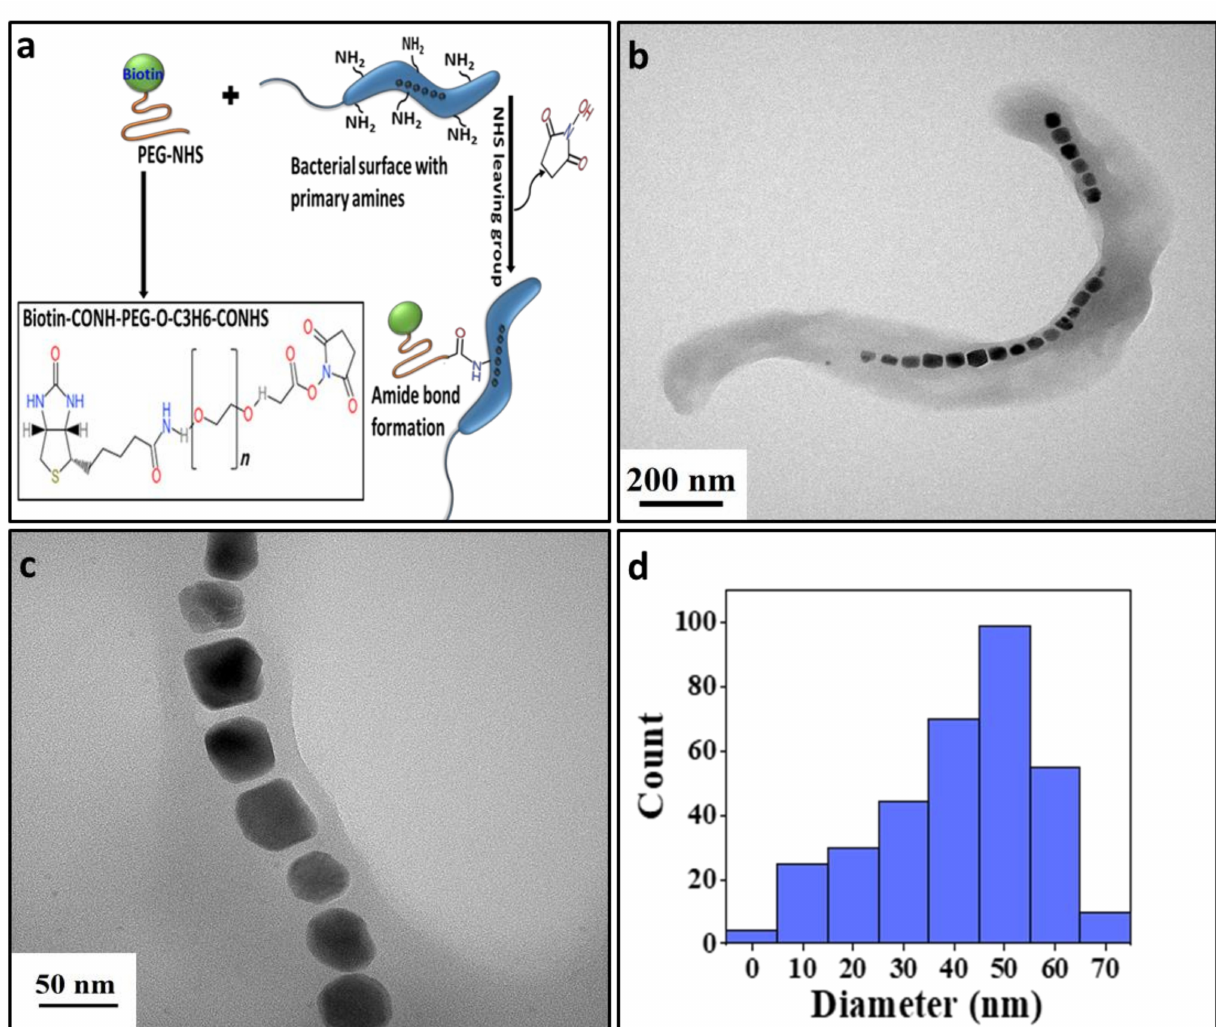
Figure 1. ( a ) Schematic representation of the loading of PEG–biotin on the bacterial surface; ( b ) TEM image showing the helical structure of MTB; ( c ) MTB with magnetosome particles; ( d ) histogram showing the size distribution of